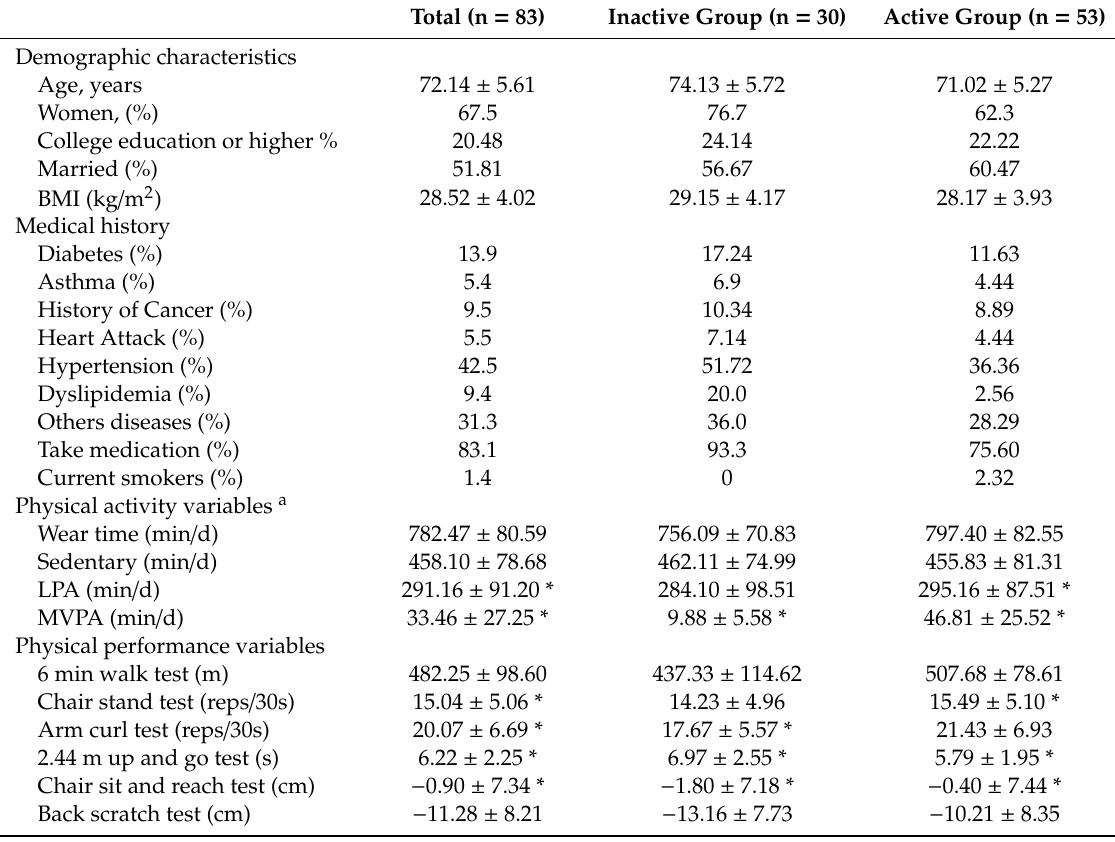
Table 1. Descriptive statistics and normality of distribution of demographic and medical history variables, sedentary time, physical activity levels, and physical fitness across all samples and within groups (active and inactive).